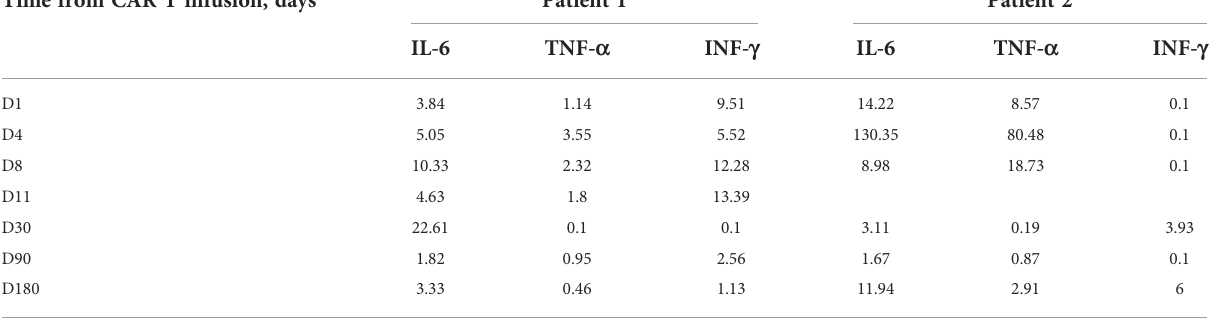
considered. PET-CT (Figure 1) suggested lymphoma after chemotherapy: deep right sternocleidomastoid muscle and cervical sheath, right cervical root, left cervical sheath, bilateral supra- and inferior clavicular regions, mediastinal thoracic inlet and upper mediastinal vascular space, multiple deep axillary nodes of variable size on both sides Lymph nodes with varying degrees of increased FDG metabolism. Peripheral blood lymphocytes were collected on September 19, 2018. Pretreatment clearance of lympohcytes with FC protocol was performed on September 29, 2018 and CAR - t cell infusion was performed on October 4. One month later the disease was assessed to be in complete remission (Table 4). During follow-up, the patient had elevated TGAb, TMAb and TPOAb, but normal thyroid function (Table 2). Secondary Hashimoto ’ s thyroiditis was considered.